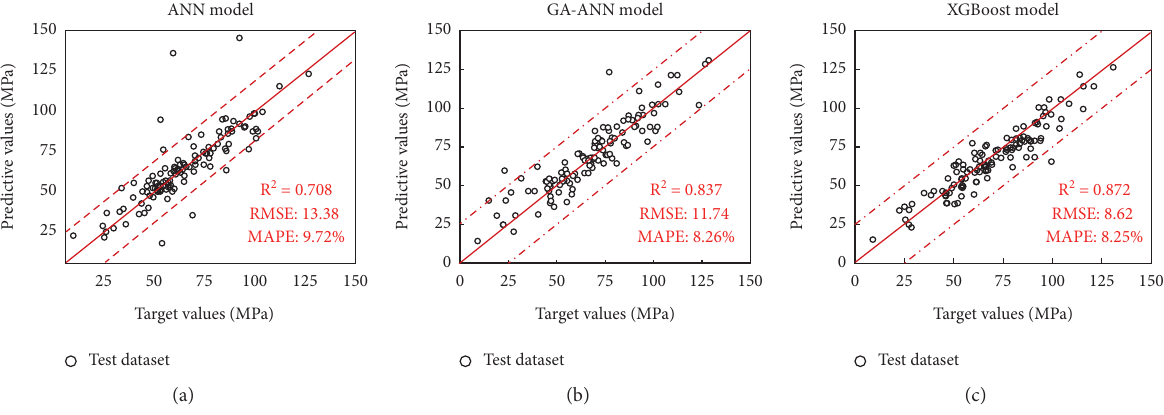
Figure 10: Prediction precision of three models for test datasets.